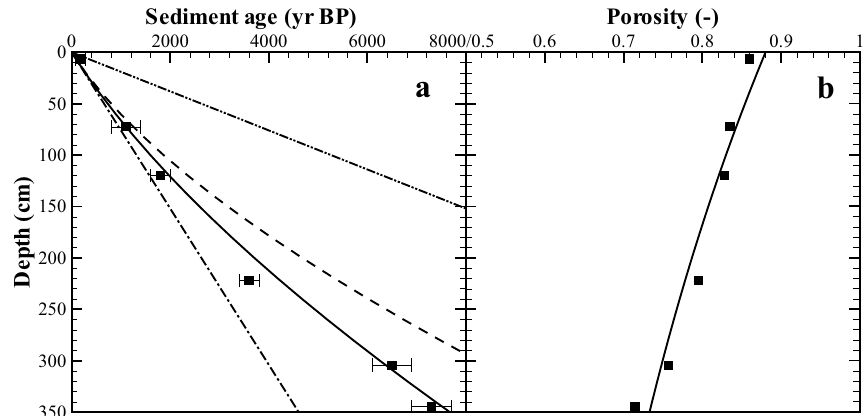
Fig. 4. (a) Sediment age ( α ) vs. depth ( z ) starting from the last part of the Ancylus Lake stage until present for a well-dated core in Arkona Basin with location (in decimal degrees) 54.95 ◦ N 13.78 ◦ E (from Kortekaas et al., 2007). Filled squares with associated error bars represent measured ages in Kortekaas et al. (2007). The best-fit solid line represents the predicted age model based on Eq. (6), which properly takes into account the changing burial velocity of solids v s | z . This correct formulation is compared with alternate (incorrect) formulations which include using the depth-dependent velocity without taking to integrated effects into account ( α = z/v s | z , dashed line), using the burial velocity of solids at the sediment water interface ( α = z/v s | 0 , dash dot line), and using the burial velocity of solids at great depth ( α = z/v s | ∞ , dash dot dot line). (b) Porosity measurements (filled squares) and simulated porosity profile (line) for the same core. The porosity profile was used for the above calculations.Note that the maximum depth shown coincides with the HORM